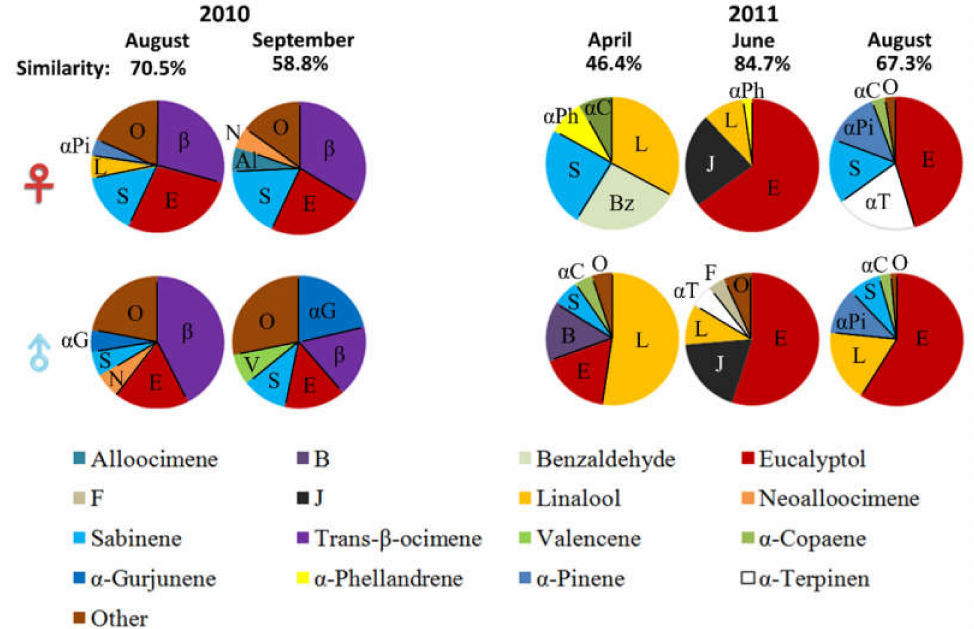
Figure 3. Seasonal changes in volatile compounds in receptive female and male figs of Ficus septica in central Taiwan.